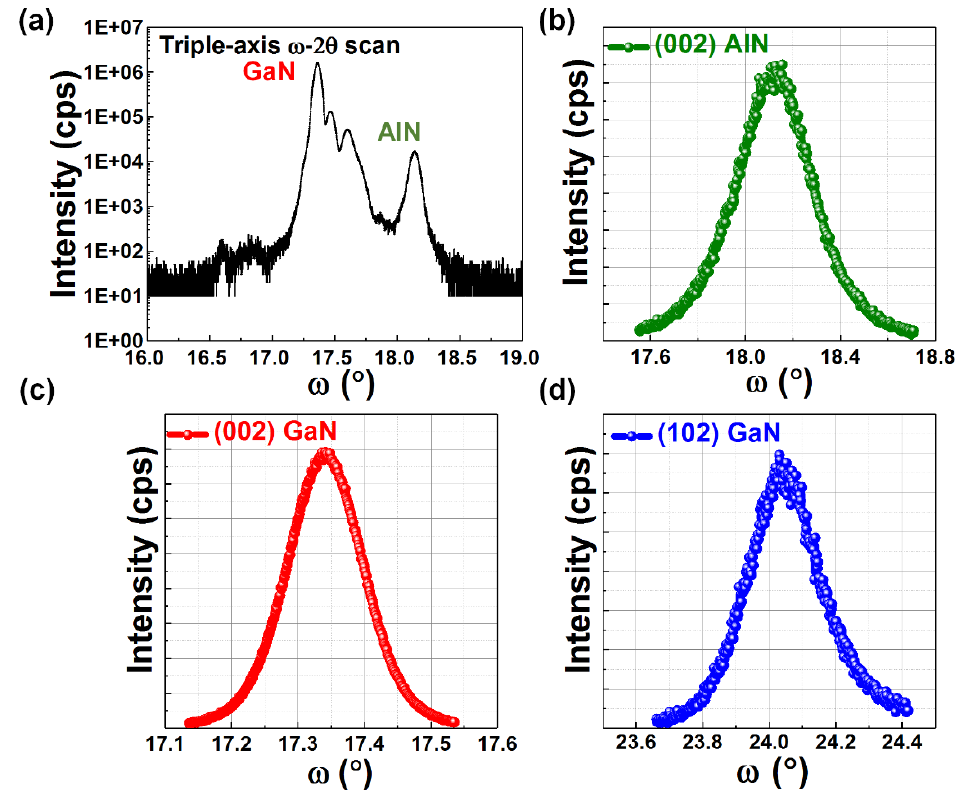
Figure 3. XRD results: ( a ) ω -2 θ scan aligned on AlN and XRD rocking curves of ( b ) (002) AlN, ( c ) (002) GaN and ( d ) (102) GaN.